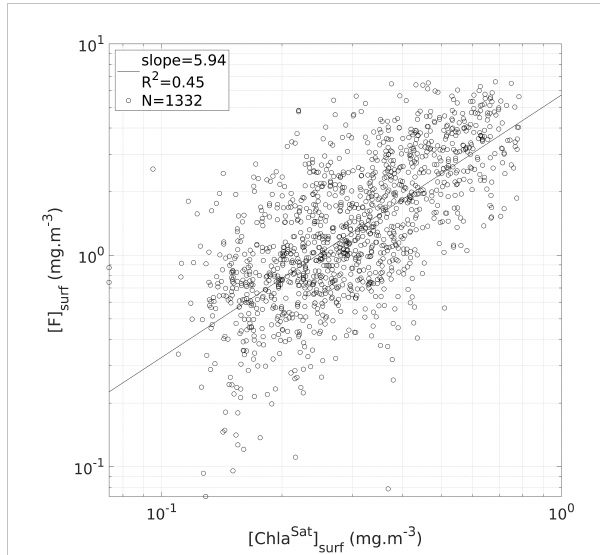
FIGURE 4 Illustration of the second step of the [F Fluo ] data calibration (see Section 2.4). Estimates of surface [Chla] derived from intercalibrated [F] data ([F] surf ) compared to satellite estimates of surface [Chla] ([Chla Sat ] surf ). The black circles represent the sample points (in total: 1 332 matchups are displayed) and the black line materializes the linear regression of all the sample points (slope = 5.95; R 2 = 0.45; N = 1 332